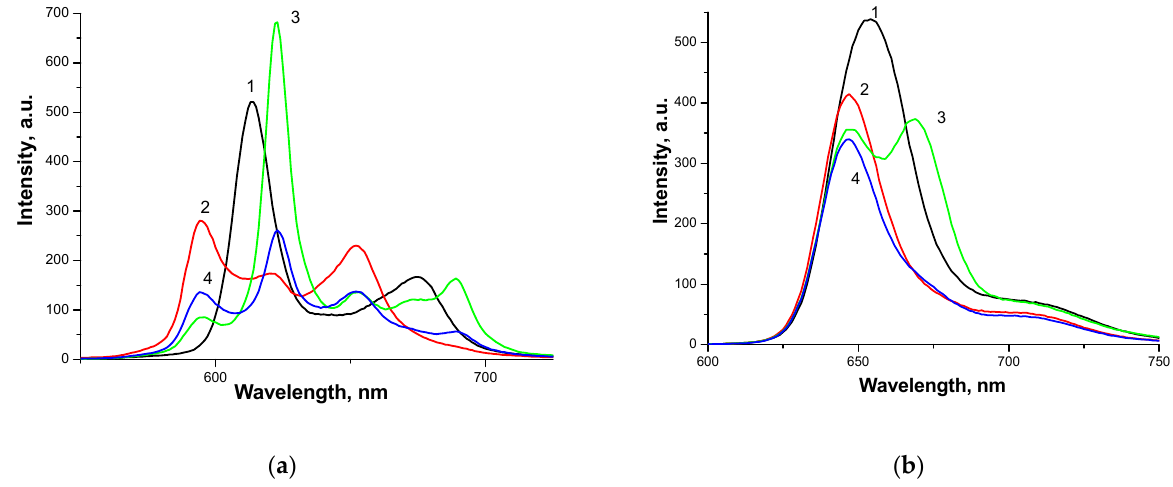
Figure 5. Fluorescence spectra for PS: DMG ( a , curve 1) and Ce6 ( b , curve 1), PS complexes with chitosan (curve 2) and for ternary systems: PS-PVP-CT 100 (curve 3), PS-F127-CT 100 (curve 4). The concentration of porphyrin is C = 5× 10 − 6 M, C CT100 = 6× 10 − 4 M, C AP = 10 − 4 M.